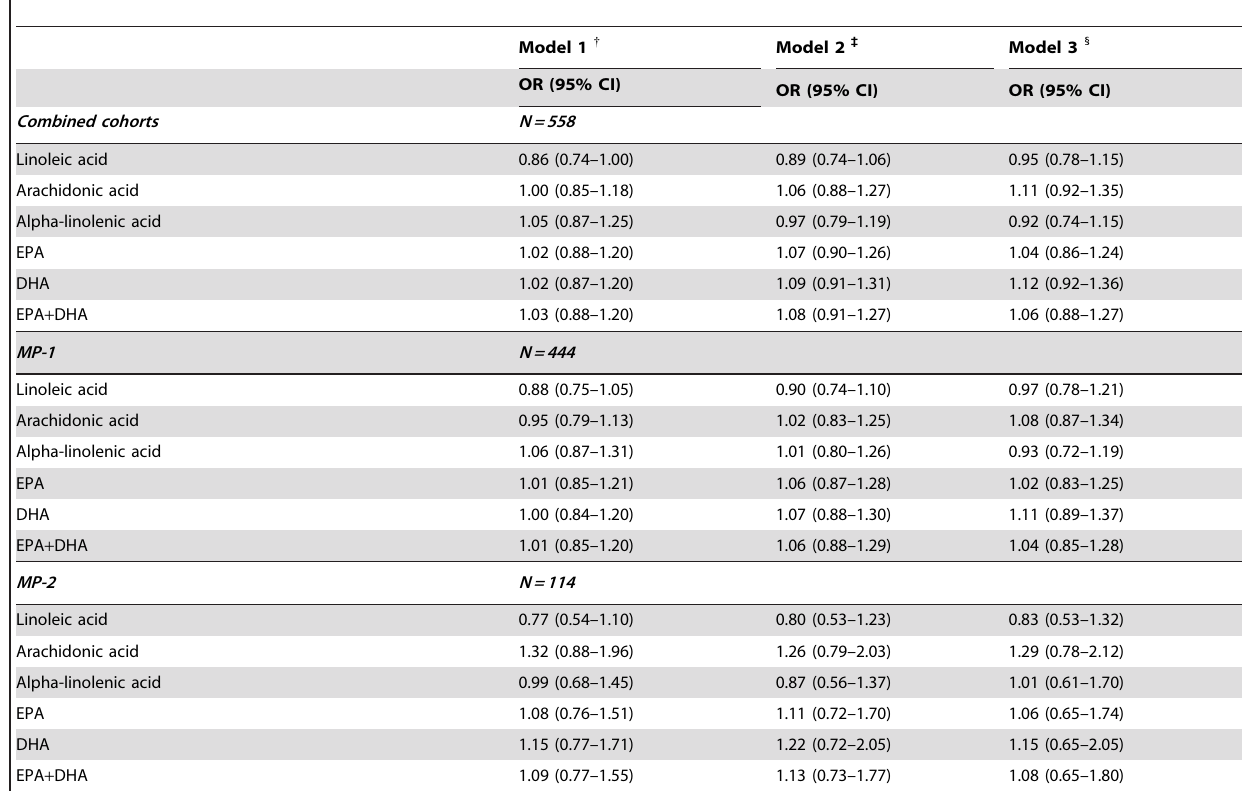
Table 3. Associations between plasma cholesteryl ester fatty acids and fatal CHD, matched by age, gender, cohort, and enrollment date.*